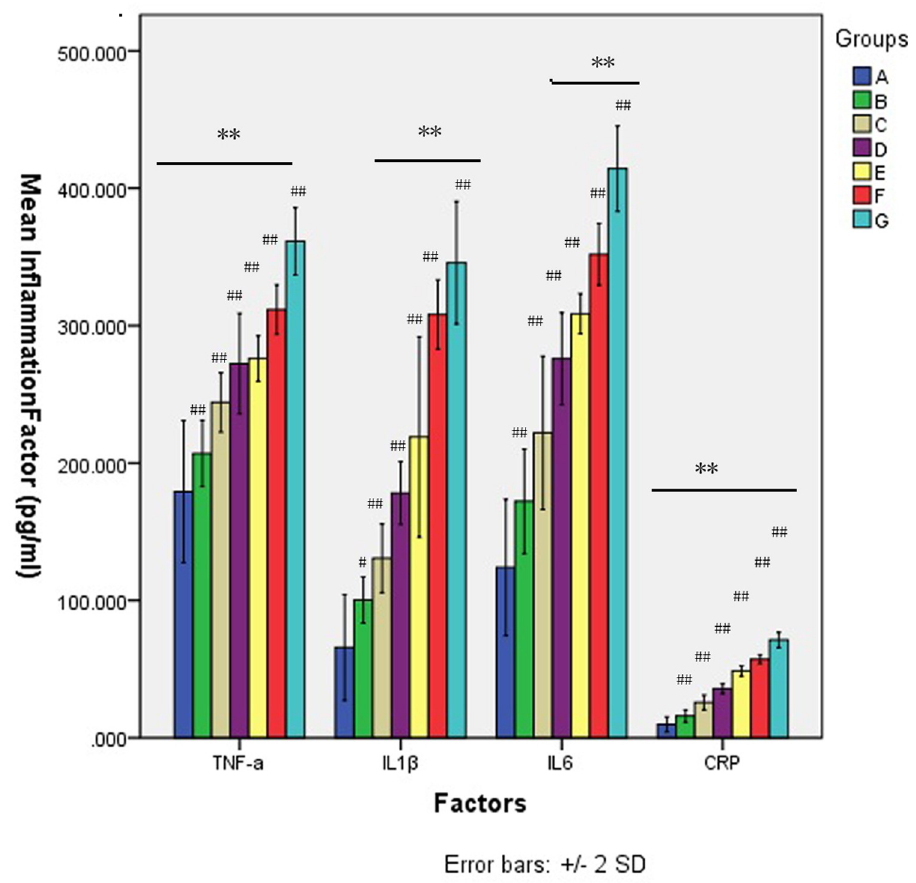
Fig 7. Comparison of inflammation factors between groups and within groups. �� P < 0.001, Comparison between groups; # = 0.001,## < 0.001,Comparison for experiment groups vs control groups.